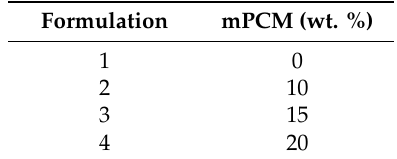
Table 5. Sample formulations under